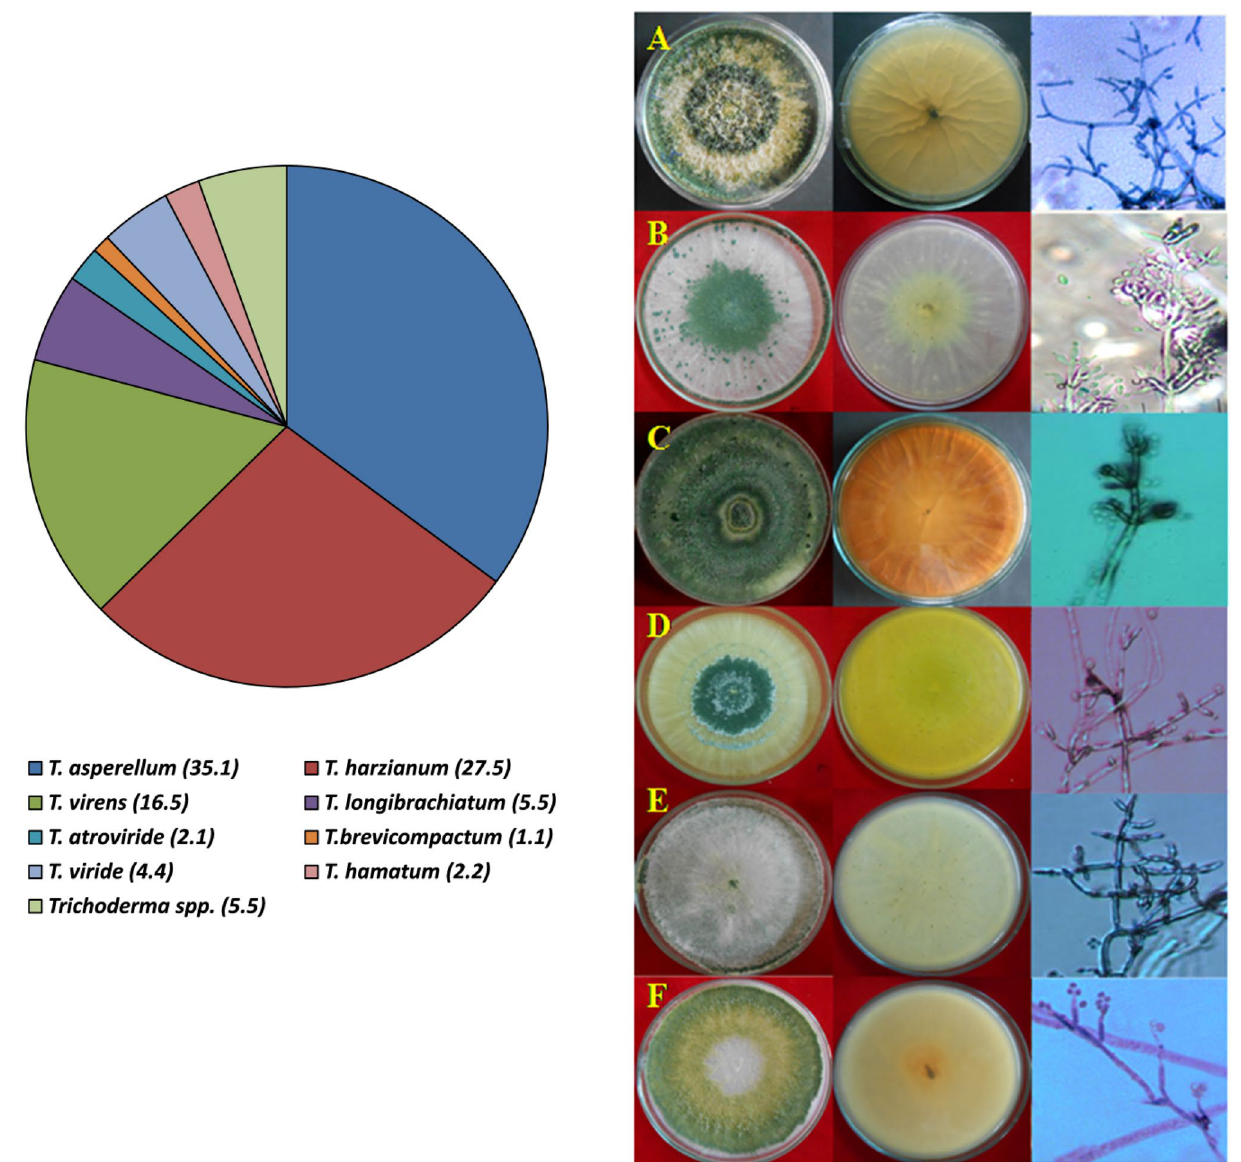
Figure 1. Diversity of Trichoderma spp. across different agroclimatic zones of India. The values in the parenthesis represents % Trichoderma . A— T. asperellum ; B— T. harzianum ; C— T. virens ; D— T. longibrachiatum ; E— T. atroviride and F— T. brevicompactum